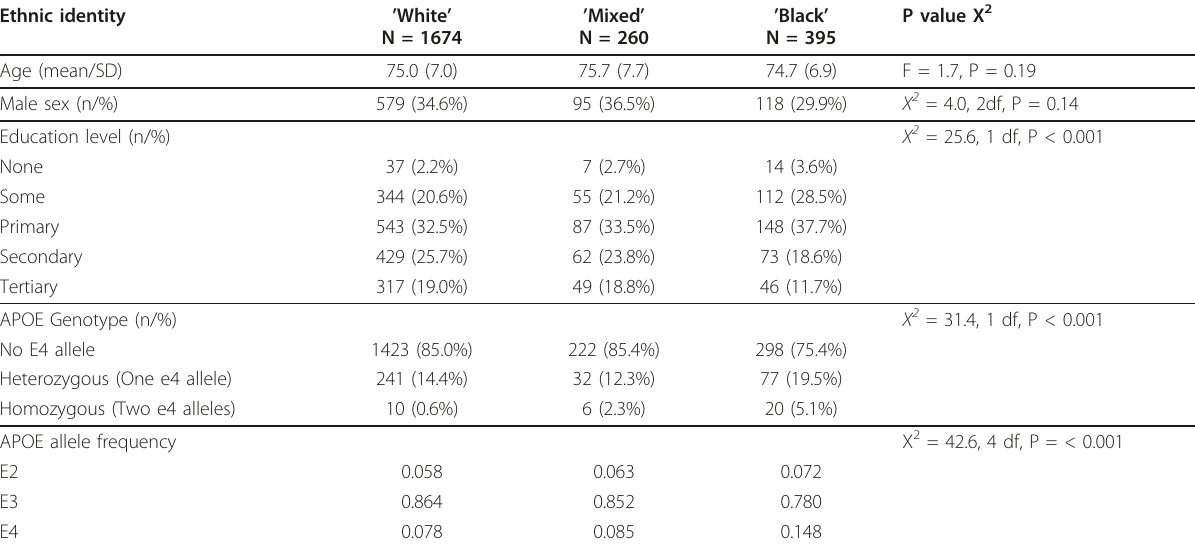
Table 2 Distribution of sociodemographic characteristics, APOE genotype and APOE allele frequency by ethnic identity Ethnic